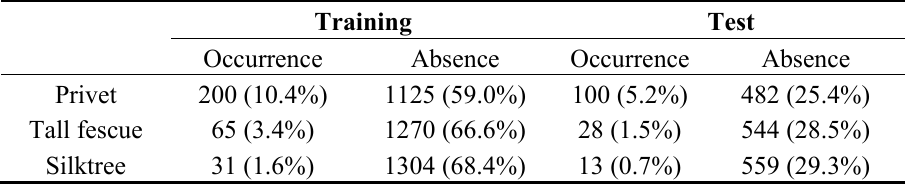
Table 2. Total number of points, for the occurrence and absence of three species, separated into training and test datasets.